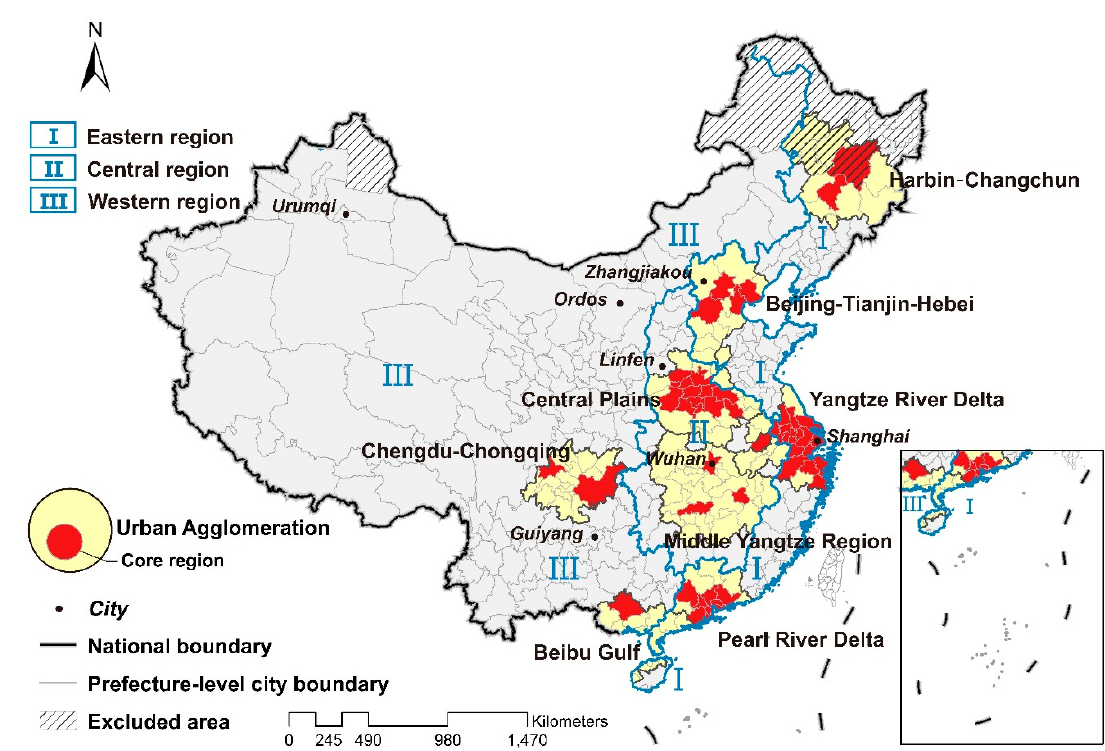
Figure 1. Spatial distribution of the study areas in China.